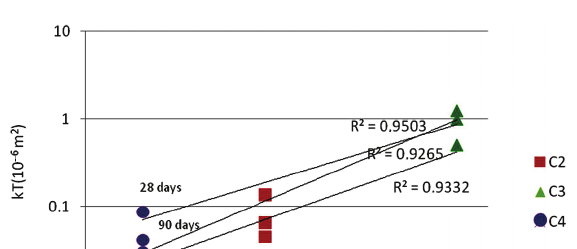
Table 8. Standard deviation of compressive strength